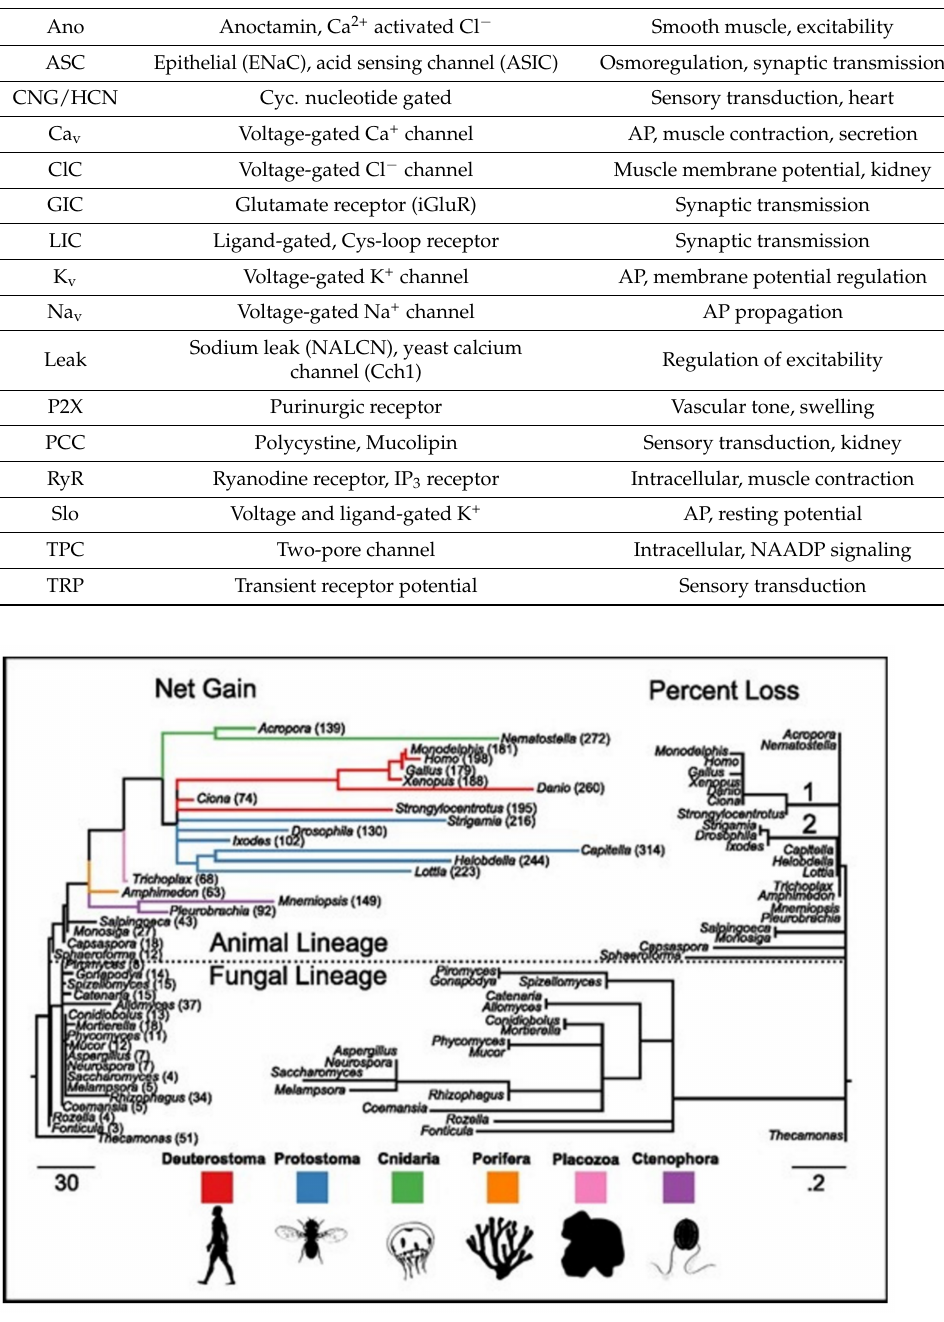
Figure 4. The families of the ion-channels in opisthokont evolution. Both trees contain similar topologies. The lengths of the branch of the left tree are actually net gain, gains-losses. The lengths of the branch of the right tree are the percent loss, losses-gains as a% of the parent copy number. Total ion channel numbers in every taxon are presented on the left tree. Two animal branches having large loss events have been labeled-the common deuterostome and ecdysozoan